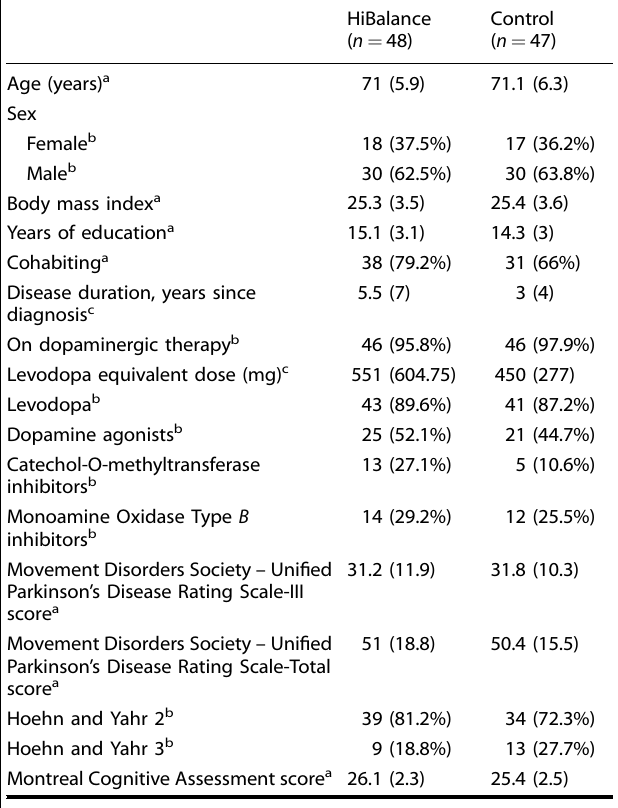
Table 1. Baseline characteristics of the intention-to-treat